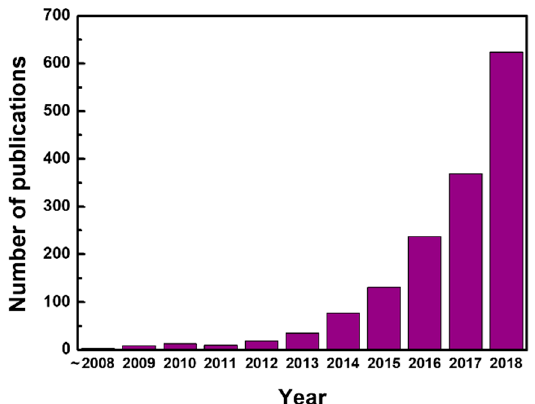
Figure 1. The number of papers with the topics of metal–organic frameworks (MOFs) and electrocatalysis, electrocatalytic, or electrochemical senor, published in each year, obtained from Web of Science database. It should be noted that all publications using MOF-derived and MOF-templated materials are counted.